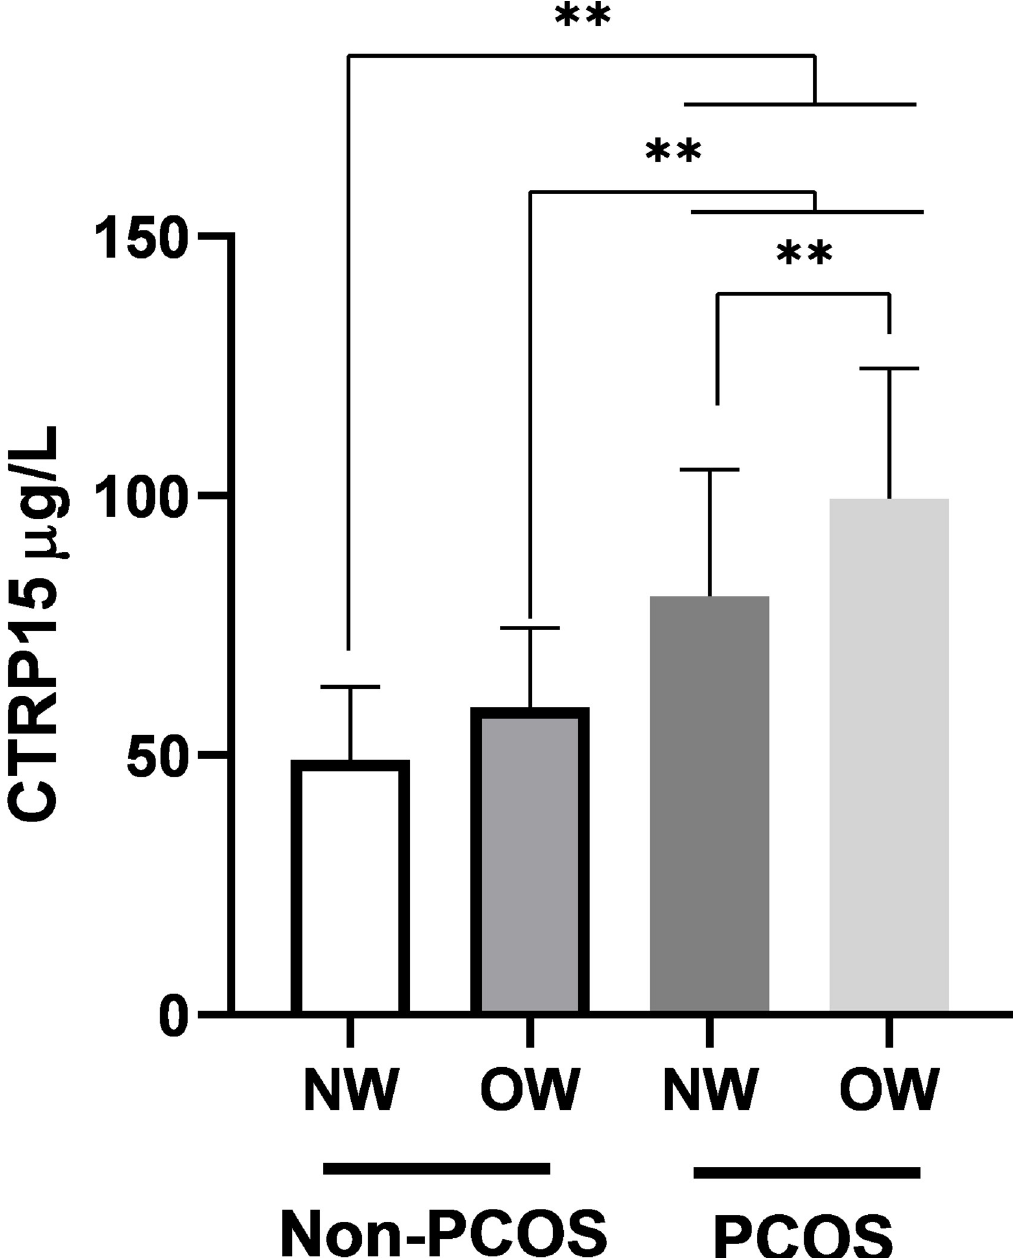
Fig 1. Serum levels of CTRP15 in normal-weight and overweight/obese individuals. Comparison was made using one-way ANOVA supplemented with Bonferroni test. PCOS: Polycystic ovary syndrome; NW: Normal-weight; OW: Overweight/obese. �� P <